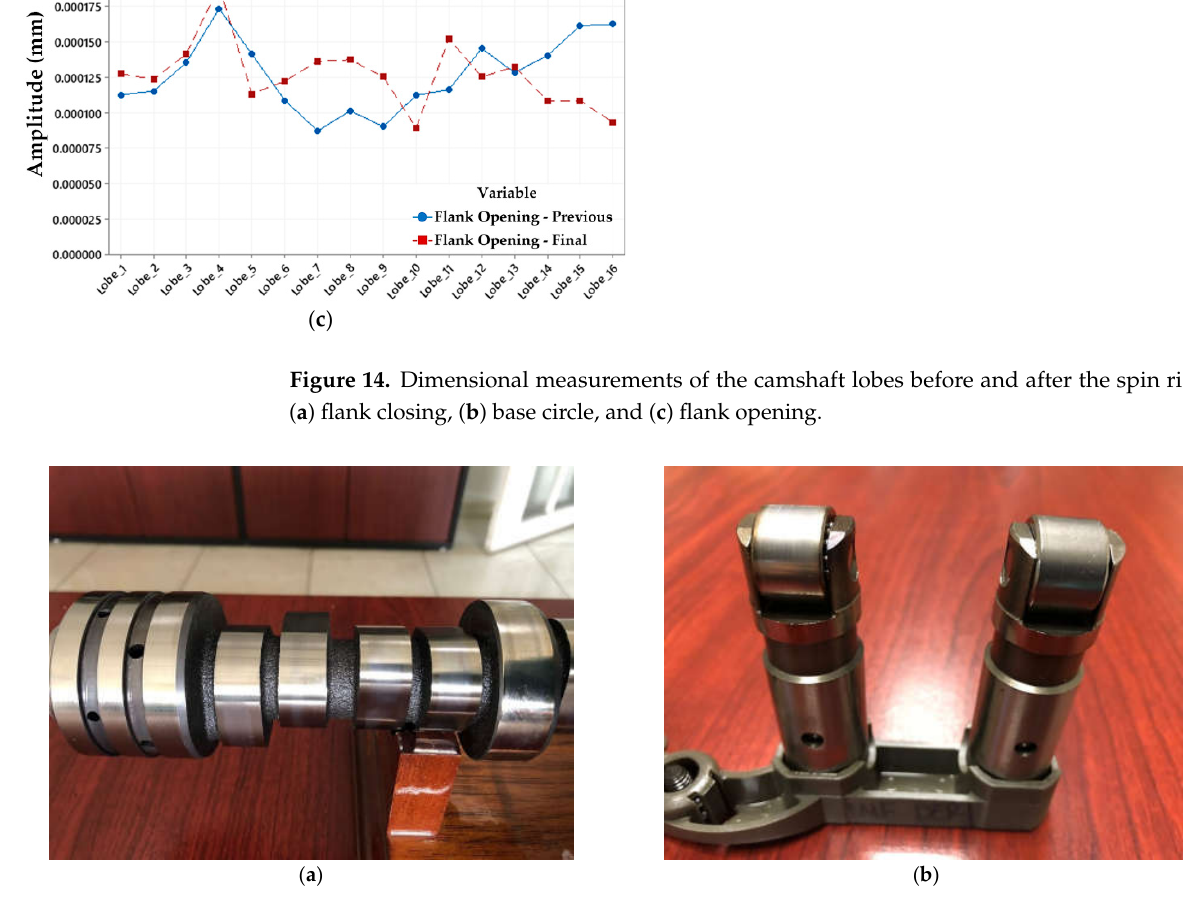
Figure 15. Condition of parts after spin rig test ( a ) lobe surfaces and journals, and ( b ) roller surfaces.